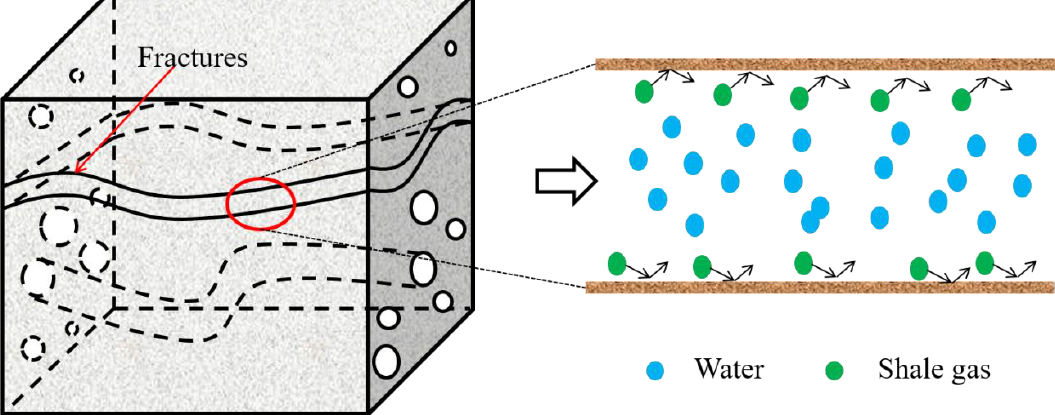
Figure 2. A two-phase flow in a fracture network [1].